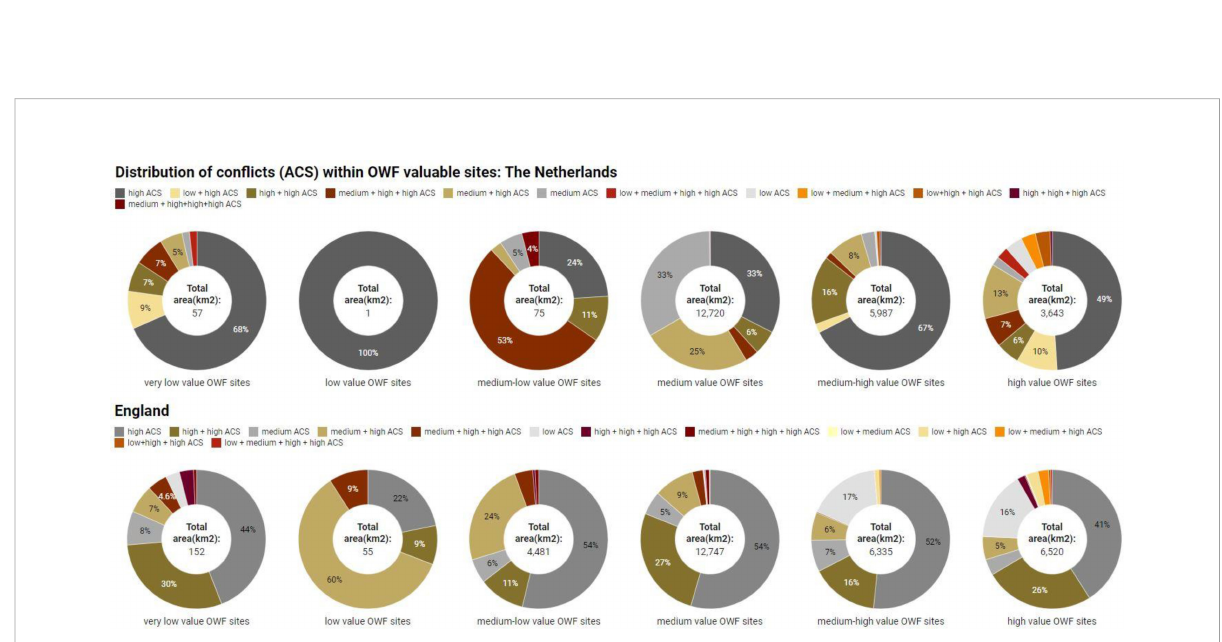
FIGURE 14 Spatial distribution (cumulated area of con fl ict) of con fl icts (ACS) within the OWF valuable sites, for fi sheries sea user group types.